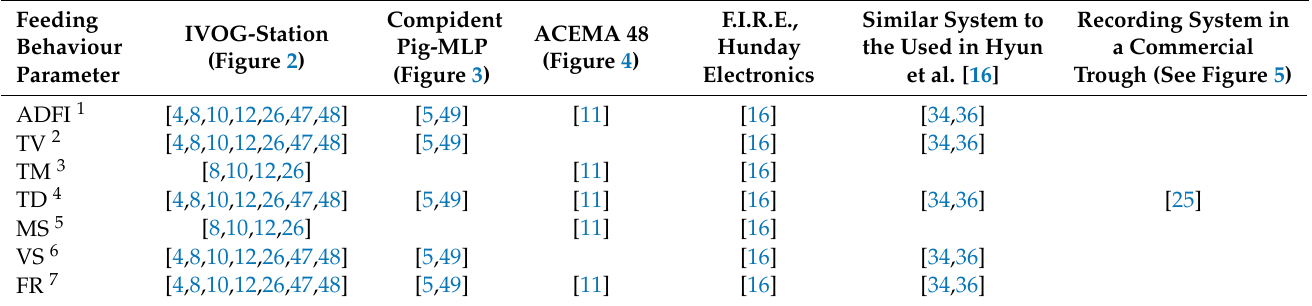
Table 3. Summary of the automatic feeding systems used and of the feeding behaviour habits measured in previous